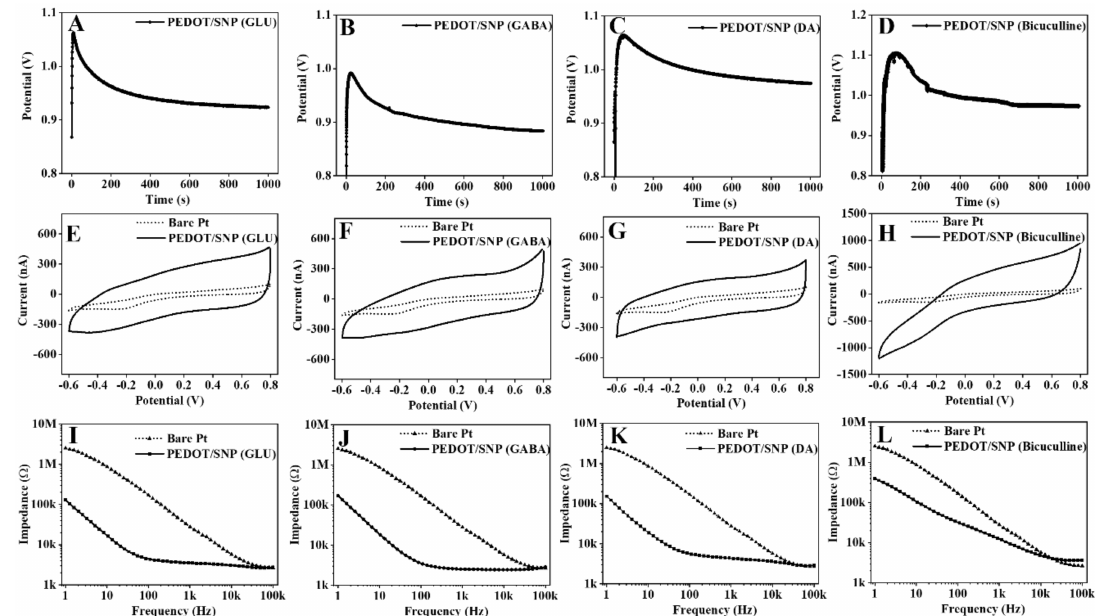
Figure 1. Chronopotentiometry coating ( A – D ), CV scan ( E – H ), and EIS ( I – L ) of drug loaded conducting polymer films on Pt surface. These films include PEDOT/SNP (GLU), PEDOT/SNP (GABA), PEDOT/SNP (DA) and PEDOT/SNP (Bicuculline). The applied charge density for the coating deposition was 320 mC/cm 2 .